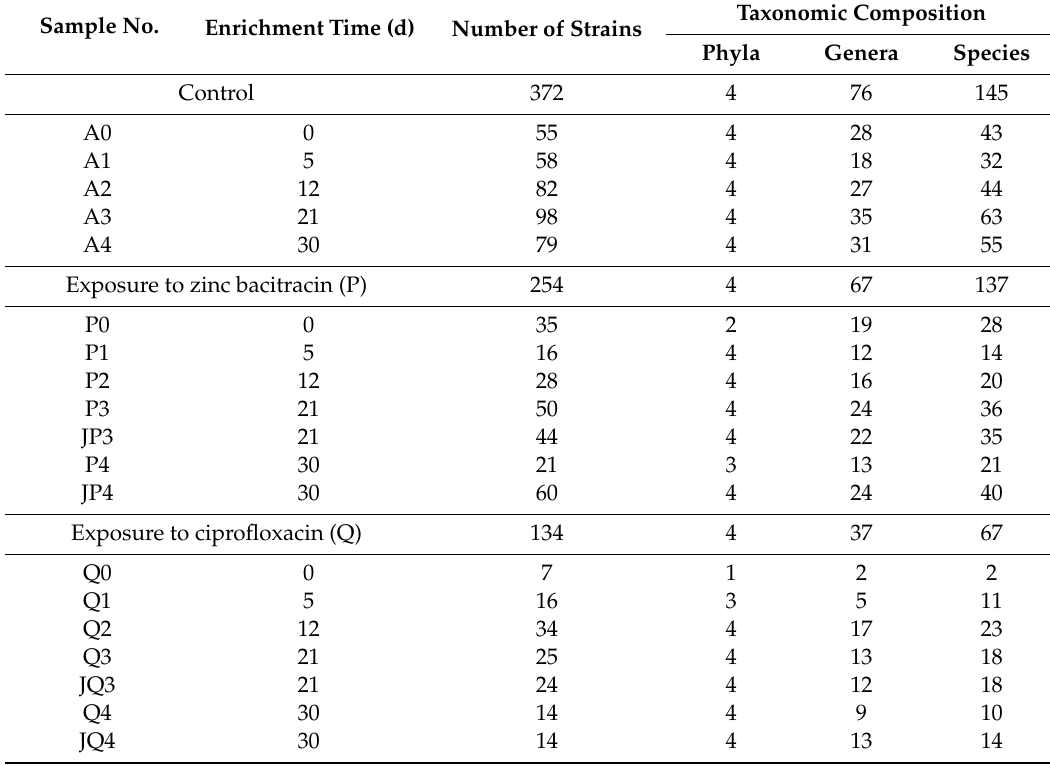
Table 2. The number of isolates and taxonomic composition of culturable bacteria. Sample No.